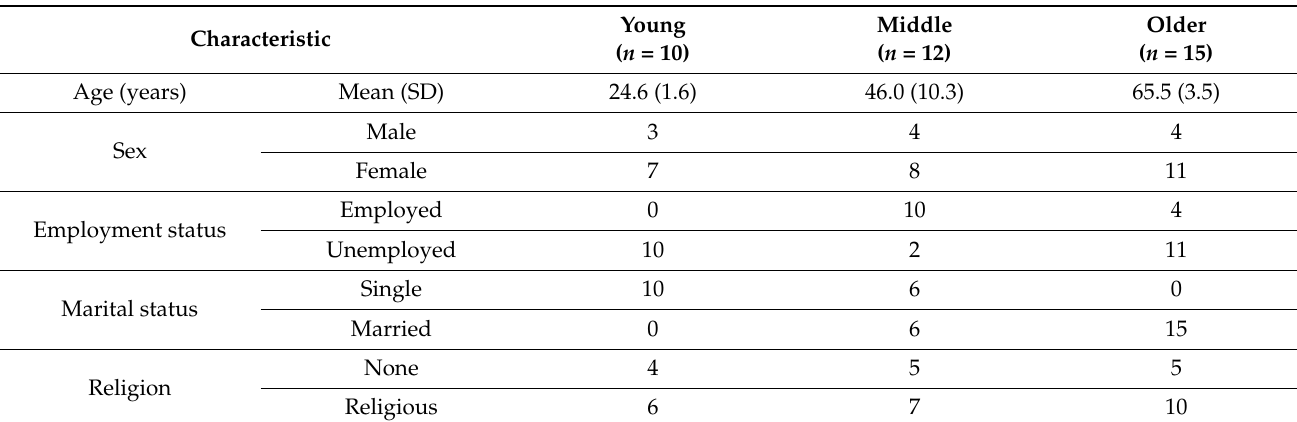
Table 1. Participants’ characteristics by age